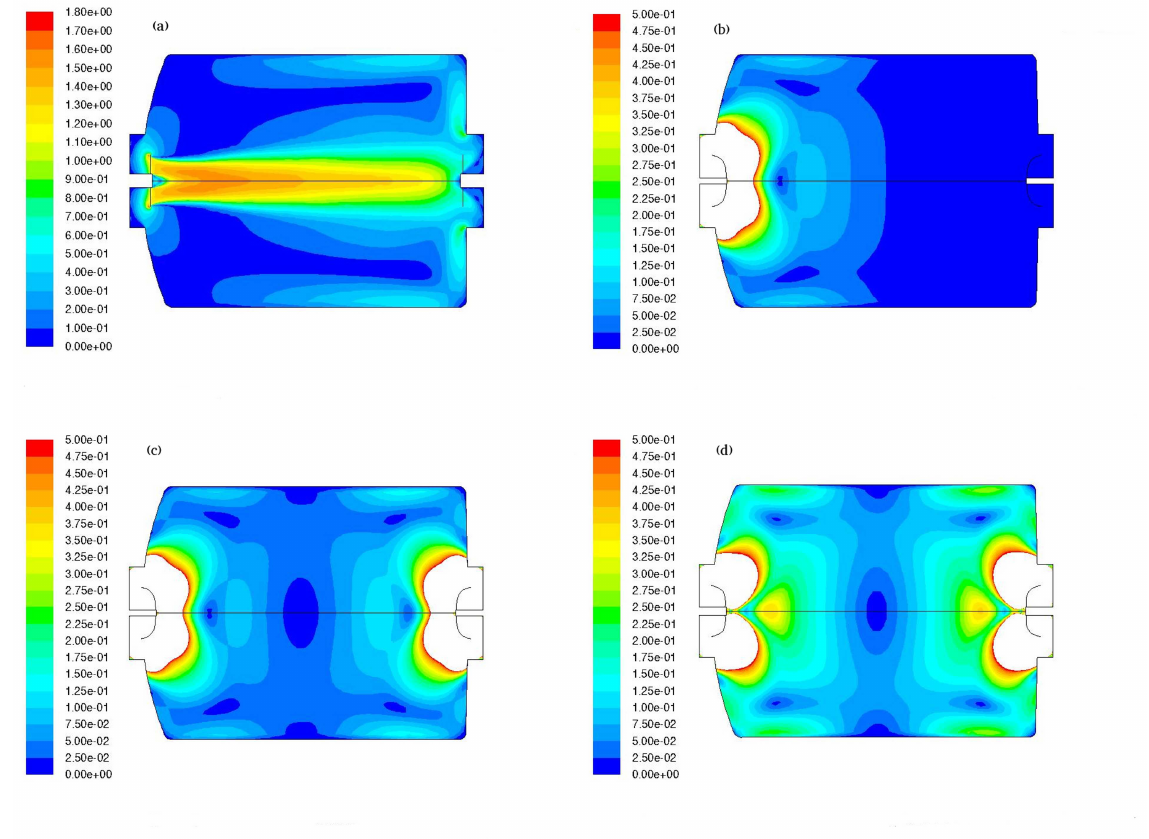
Fig. 5. Calculated cross sectional profiles of the velocity magnitude. (a) 1-fan configuration with flat fan approach, (b) 1-fan configuration with modified arc shaped pressure jump layer adjusted to the measured velocity profile 50cm above the mixing fan (CLOUD-1), (c) 2-fan configuration with fan settings as used in (b) and (d) 2-fan configuration adjusted to velocity profile of the CLOUD-5 set up (with hoods around the